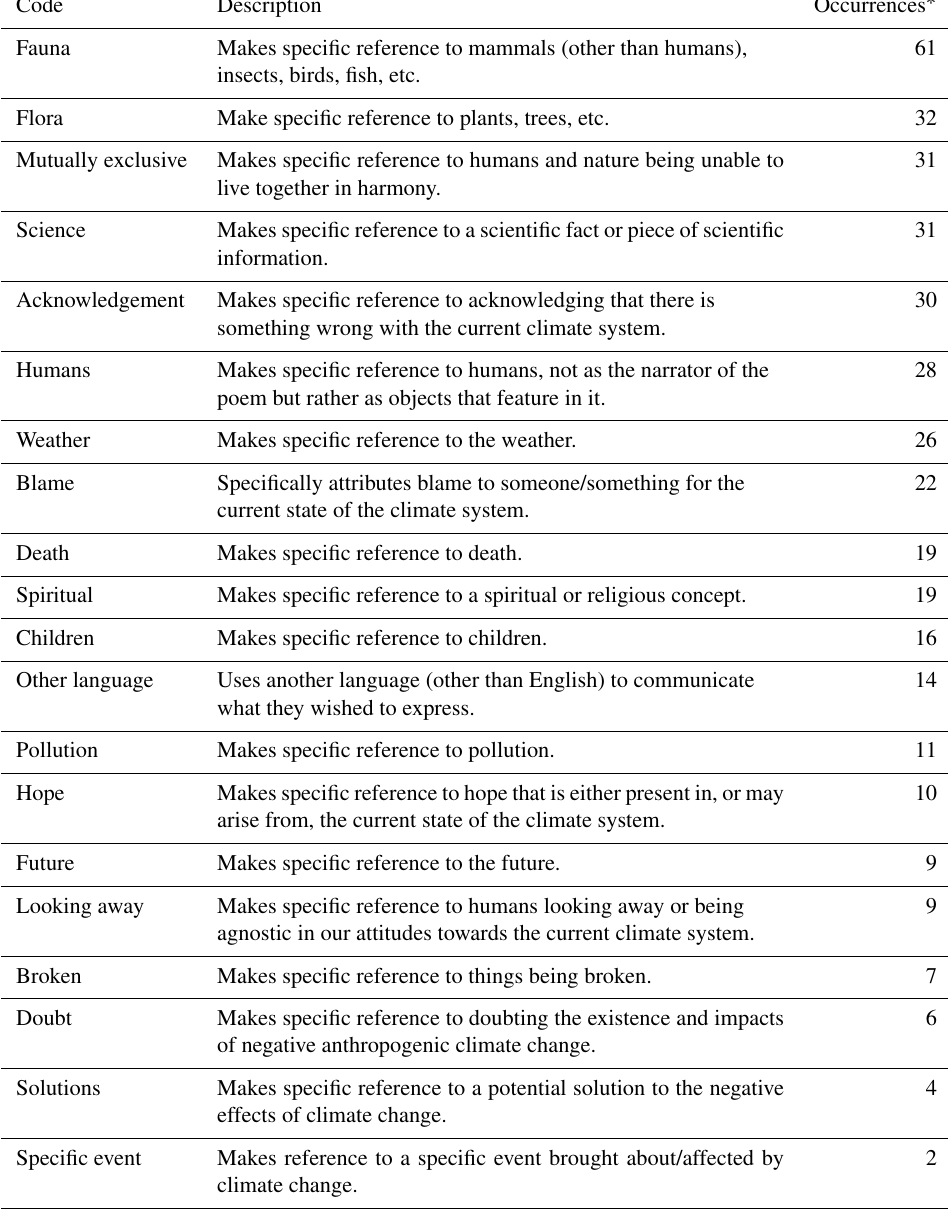
Table 1. The codes that emerged from the content analysis. Code Description Occurrences ∗ Fauna Makes specific reference to mammals (other than humans), insects, birds, fish, etc.